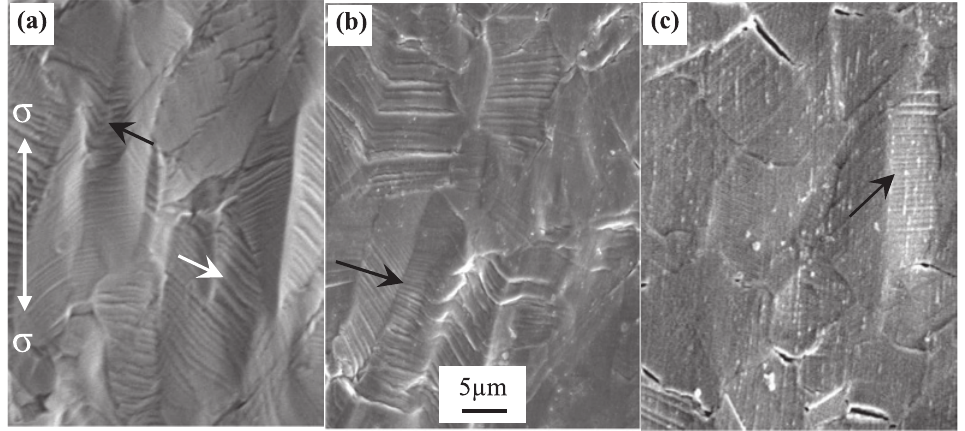
Fig. 6: Surface morphology away from fracture of GH4169 alloy stretched at different temperatures. (a) Stretching at 20 °C, (b) stretching at 500 °C, (c) stretching at 650 °C